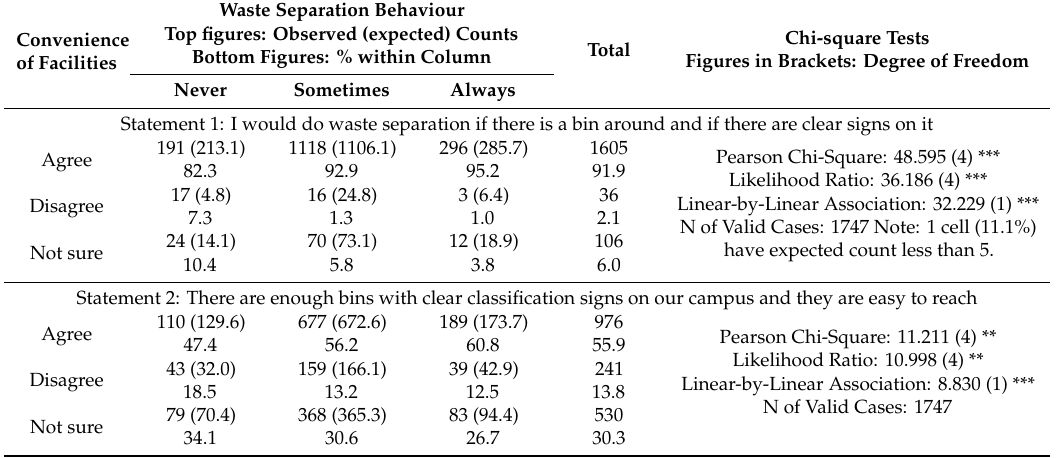
Table 4. Convenience of waste sorting facilities and waste separation